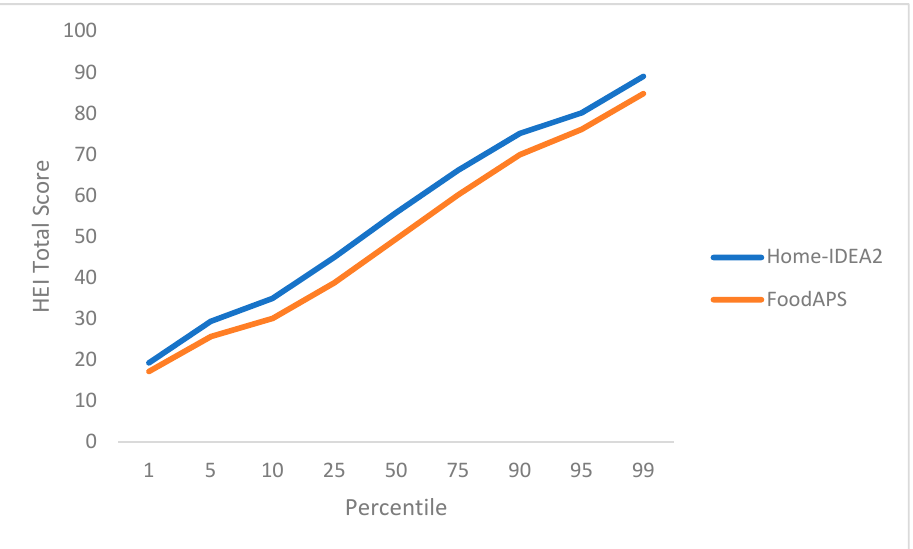
Figure 2. Percentile distribution of HEI total scores for the Home-IDEA2 and FoodAPS to test sensitivity and range between scores.